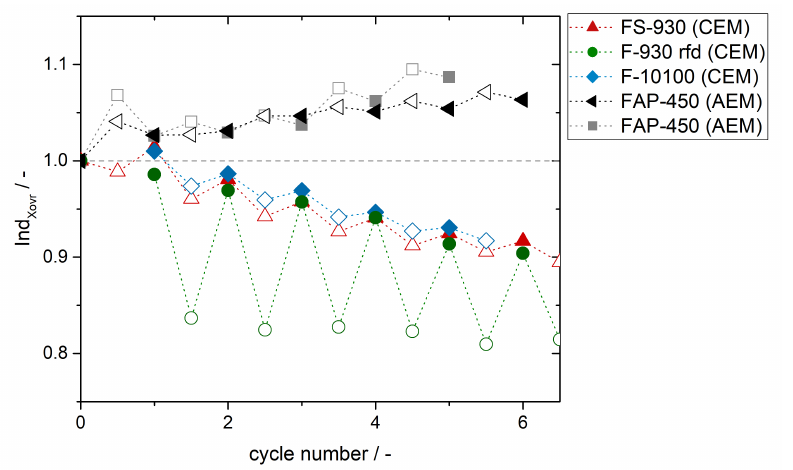
Figure 7. Crossover index Ind Xovr for state of charge (SOC) estimation from redox-potential measure- ments in the positive half-cell and negative half-cell, battery cell with membranes and parameters for charge and discharge cycles in Table 1. According to cycle numbers full numbers display a discharge half-cycle (filled icons) and half numbers (x,5) display a charge half-cycle (empty icons). Ind Xovr for the tested CEM are smaller than 1 and Ind Xovr for the thinner membrane (FS-930) is lower respectively deviates stronger from 1 than for the thicker membrane (F-10100) due to a higher amount of vanadium ions crossing the thinner membrane. Also the difference between Ind Xovr for the charge and discharge half-cycles is smaller for the thicker membrane since less crossover